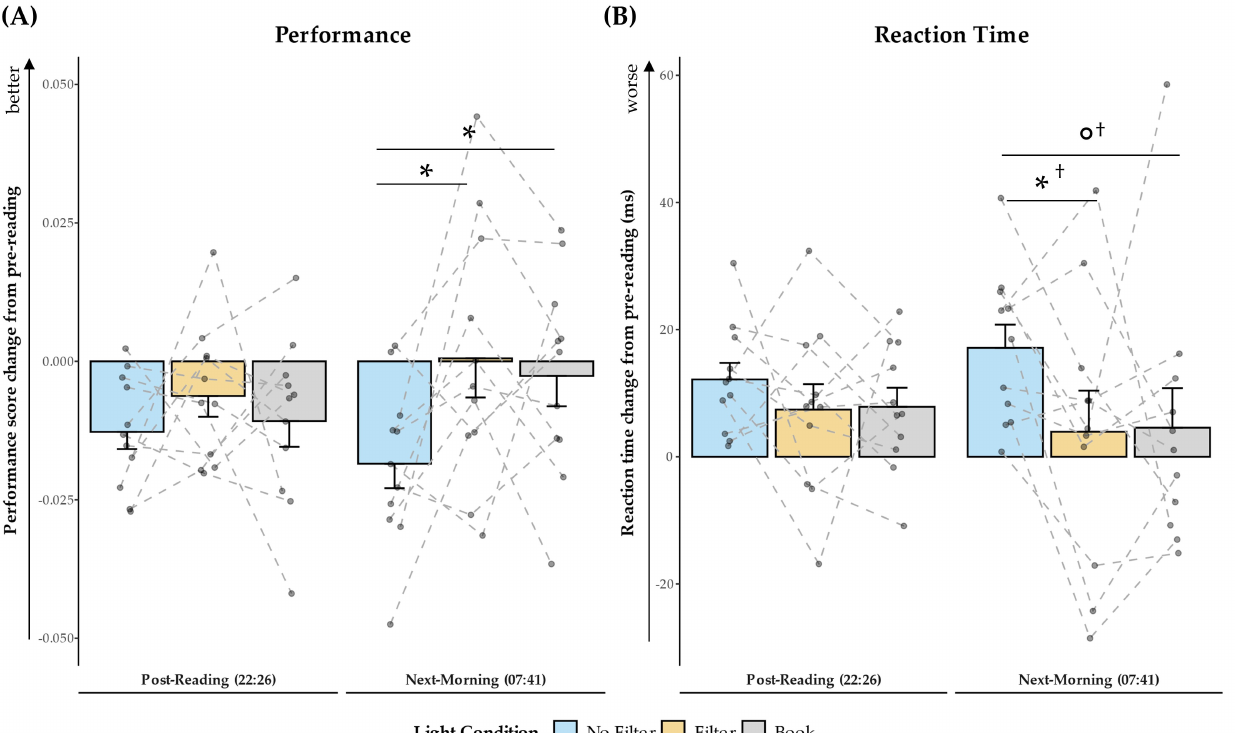
Figure 7. Baseline corrected results for the GO/NOGO task expressed as differences to pre-reading. ( A ): Mean and standard error for the change in median reaction time from pre- to post-reading and from pre-reading to the next morning across conditions with no difference post-reading but slower reaction times during the next morning in the “No Filter” condition. ( B ): Mean and standard error for the change in task performance (see Section 4.8 for the formula) analogously to ( A ) with reduced performance in the “No Filter” condition during the next morning. ◦ = p ≤ 0.10; * = p ≤ 0.05; † = p adj. >